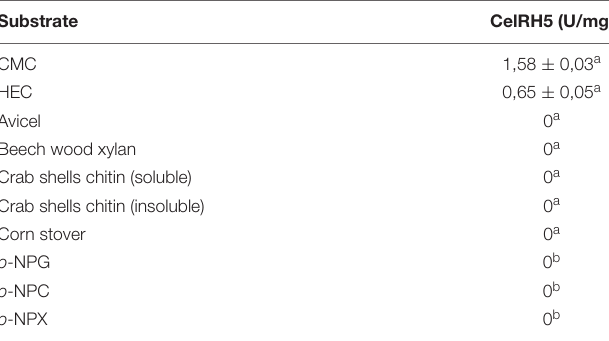
TABLE 4 | Substrate specificity of recombinant